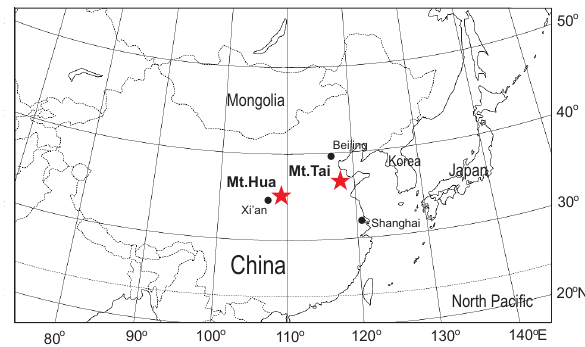
Fig. 1. A map description for the sampling locations (Mt. Hua and Mt. Tai) and their surroundings.